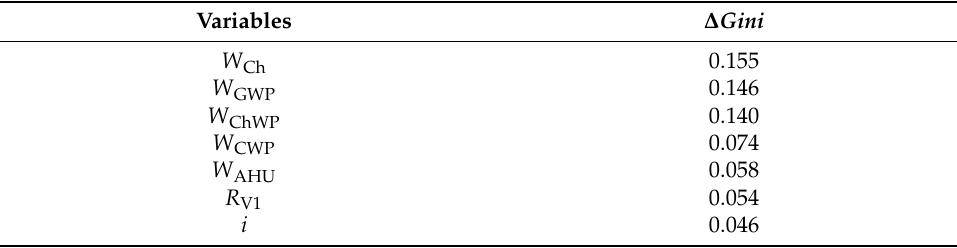
Table A5. ∆ Gini values for variables at node 3.